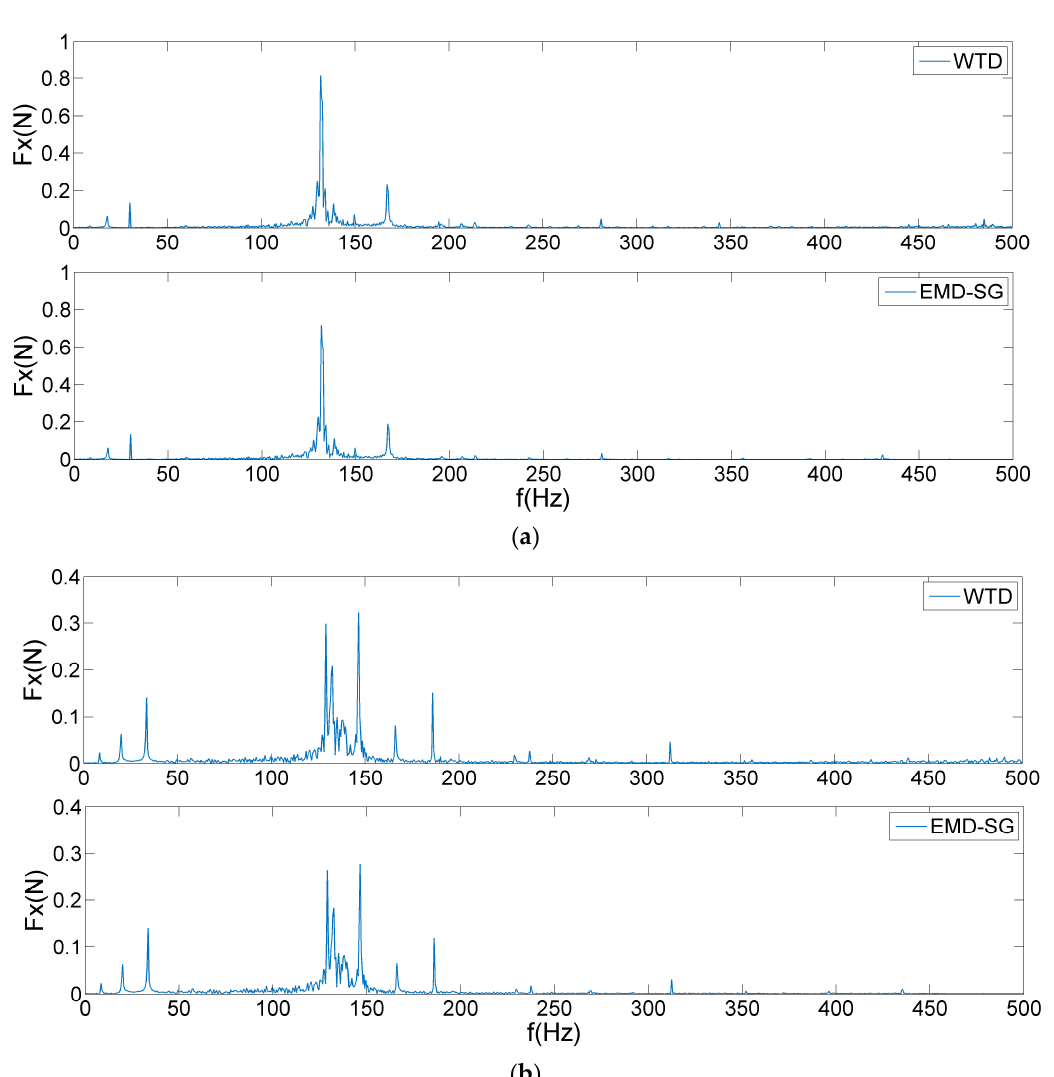
Figure 12. Peak threshold denoising of the micro-vibration signals: ( a ) 1800 rpm; ( b ) 2000 rpm.